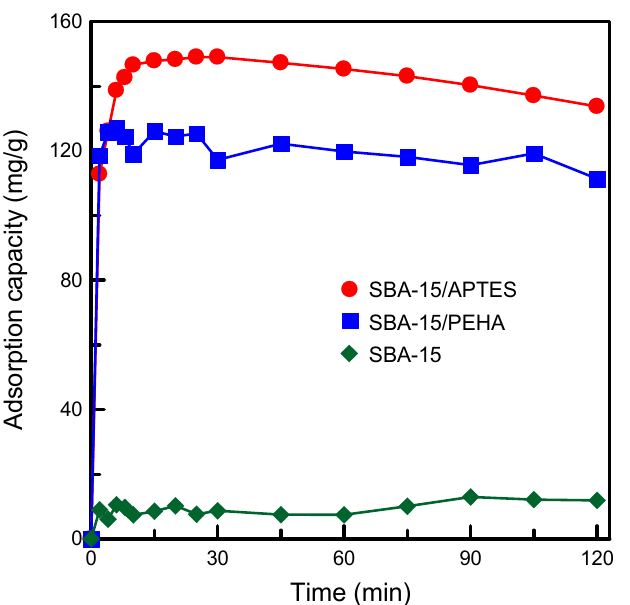
Figure 8. Effects of contact time on the adsorption performance of various kinds of adsorbents.